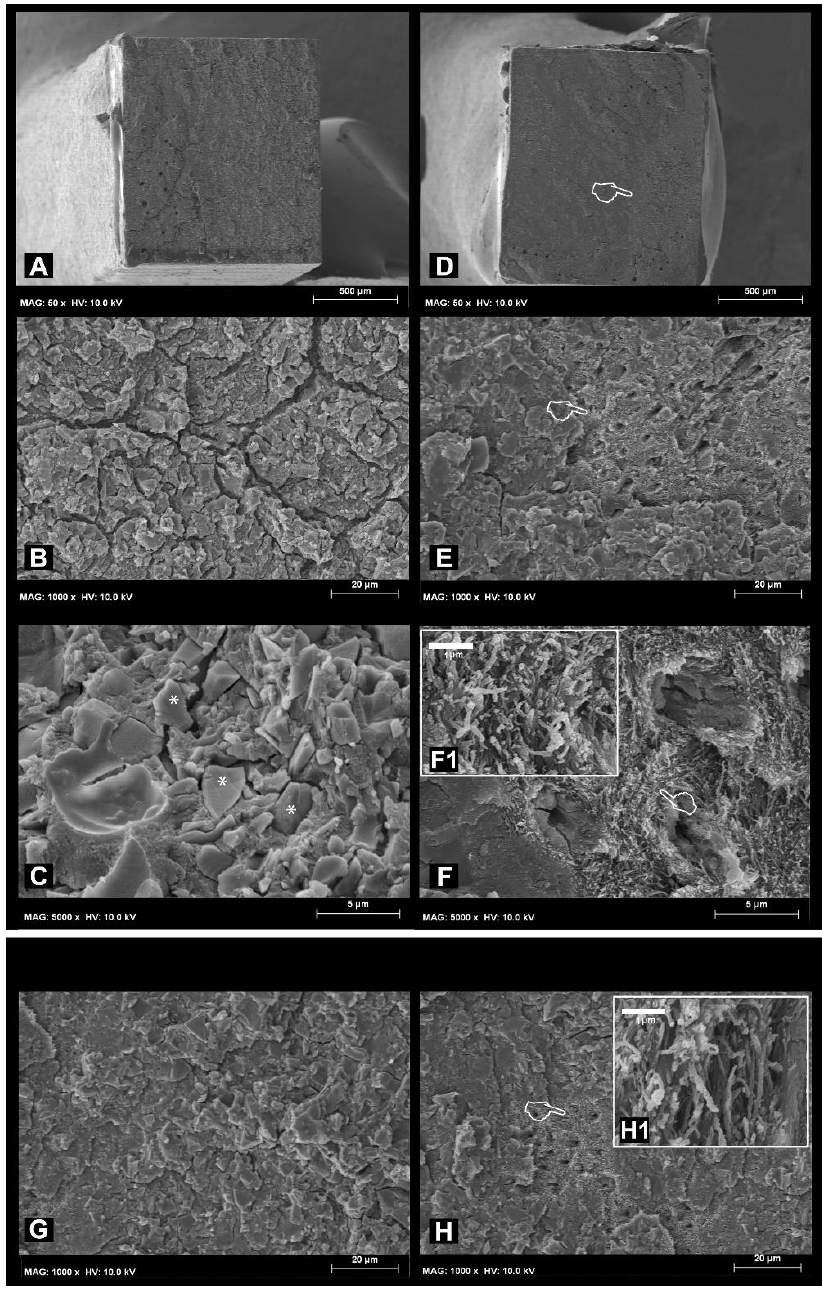
Figure 1. ( A ) Representative SEM micrograph of a specimen created with the use of no PAA applied on dentine that failed during the microtensile bong strength test in cohesive mode after 24 h of storage in water. At higher magnification, it is possible to note a surface covered by residual RMGIC ( B ) characterized by the presence of particles (*) of fluoroaluminosilicate glass ( C ). ( D ) Representative SEM fractographic analysis of specimens created with the use of PAA applied on dentine that failed in mixed mode after 24 h storage. At higher magnification, it is possible to see the presence of totally exposed unprotected dentinal tubules (pointer), and the presence of some partially demineralised residual collagen fibrils (pointer) ( E , F , F -1). ( G ) Representative SEM micrograph of specimen created with the use of no PAA applied on dentine that failed during microtensile bond strength test in cohesive mode after load cycling aging. Also, in this case it is possible to note a surface covered by RMGIC with no dentine exposure. ( H ): Representative SEM fractographic analysis of specimens created with the use of PAA applied on dentine that failed in mixed mode after load cycling aging. It is possible to see the presence of totally exposed unprotected dentinal tubules (pointer), and, at a higher magnification, it is possible to note the presence of partially demineralised collagen fibrils ( H - 1).